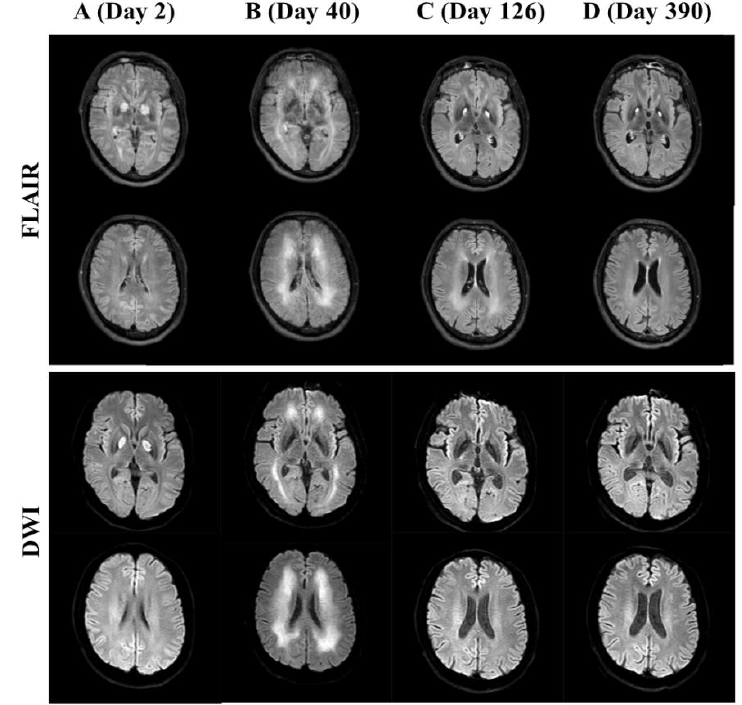
Figure 1. Serial brain magnetic resonance (MR) images. FLAIR, fluid-attenuated inversion recovery; DWI, diffusion-weighted imaging.